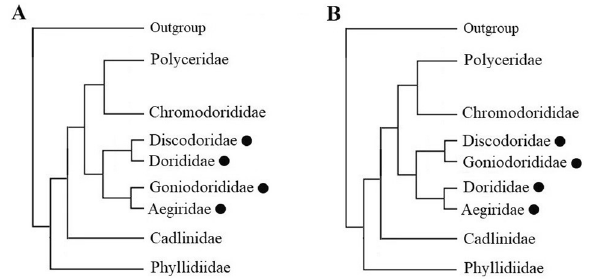
Figure 3. Interfamily relationship from this study ( A ) and constrained branching pattern ( B ) used for topology test. In the constrained tree, Discodoridae is sister to Goniodoridae and Aegiridae is sister to Dorididae. The families targeted for topology test were marked with black